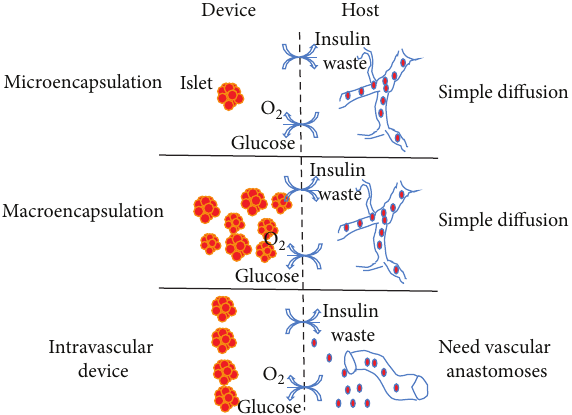
Figure 2: Schematic representation of immunoisolation device or bioartificialpancreas.Theycanbecommonlyseparatedintotwocat- egories, intravascular and extravascular devices. The latter can fur- ther be divided into macroencapsulation and microencapsulation devices. Intravascular and extravascular classifications are based on whether or not it is connected directly to the blood circulation. The macroencapsulation and microencapsulation classifications depend on whether it contains one or more islets in the